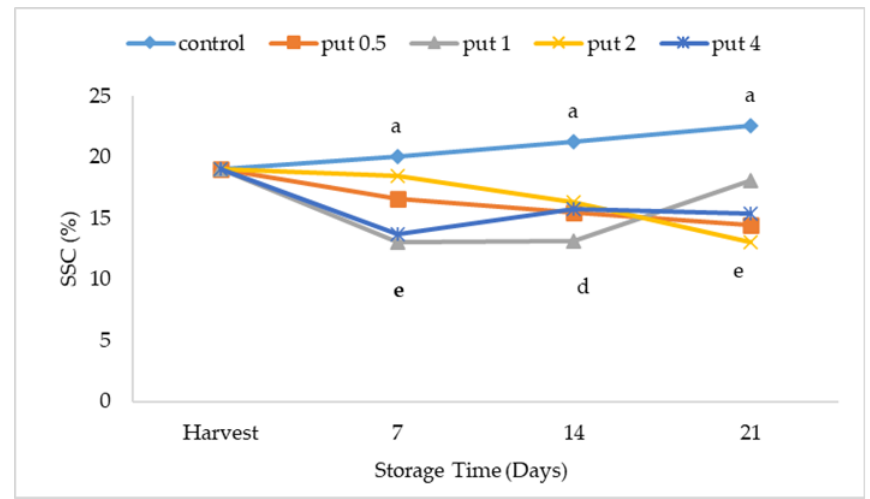
Figure 4. Effect of putrescine treatment on soluble solids content (SSC) of fig fruit during cold storage. Put 0.5, 1, 2 and 4 indicates putrescine doses of 0.5 mM, 1 mM, 2 mM, and 4 mM, respectively. According to the Tukey test, p < 0.05 does not differ between the same letters in the same harvest period.